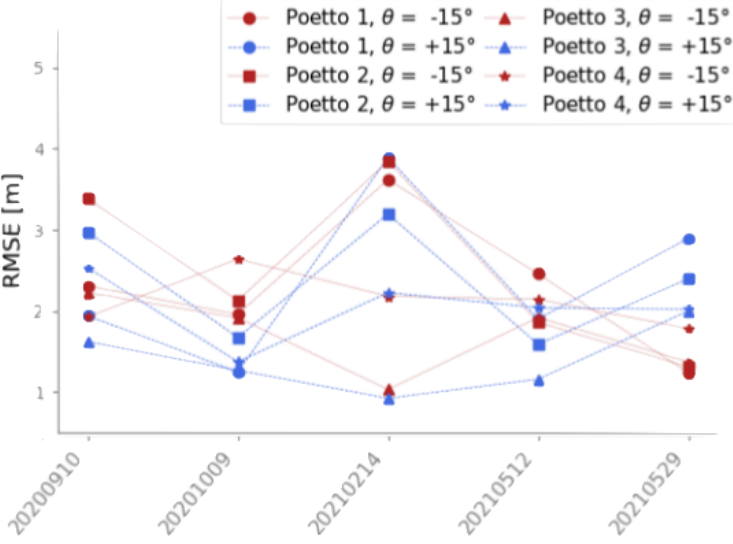
Figure 8. RMSE of the SDS profile obtained with the profiles at 90±15 ◦ of inclination (blue and red, respectively) to the one obtained with the perpendicular profiles for the Poetto beach AoIs. Symbols represent each